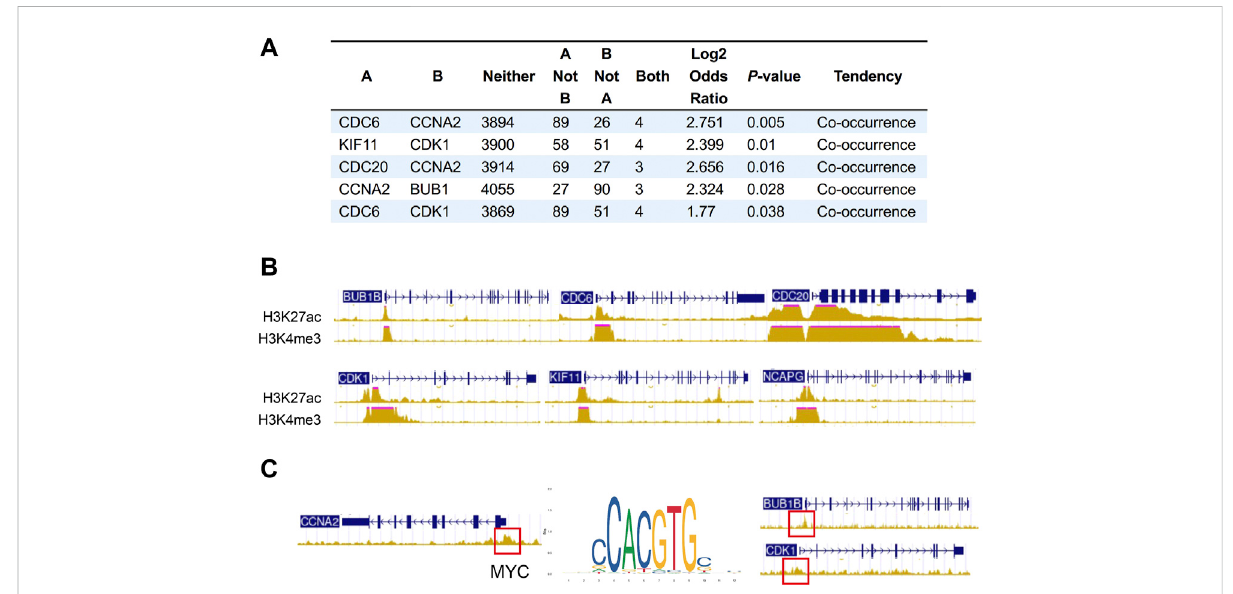
FIGURE 6 Co-occurrence of hub gene alterations in NSCLC and ChIP-seq of histone and transcription factors in A549 cells. (A) Five pairs of hub genes tendingtohaveconcurrentCNAsinNSCLC. (B)